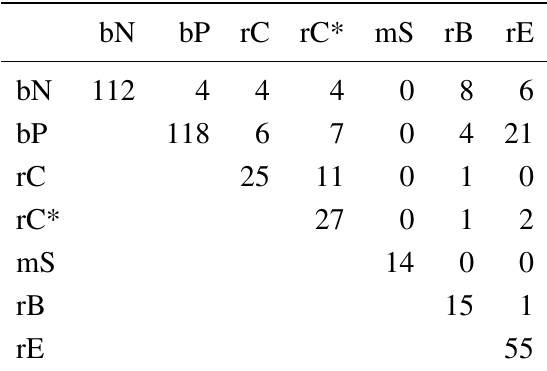
Table 2. Overlaps between the 7 functional groups defined in the